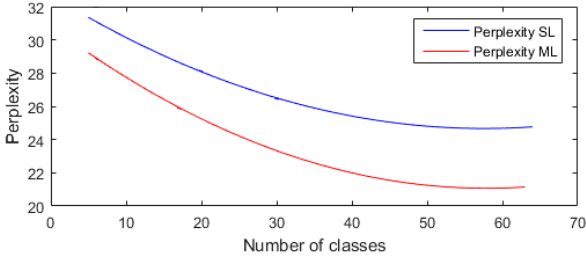
Figure 15. Perplexity curves for Sentinel-1 dataset. The inflection point is 34 for both Single-Look and Multi-Look.